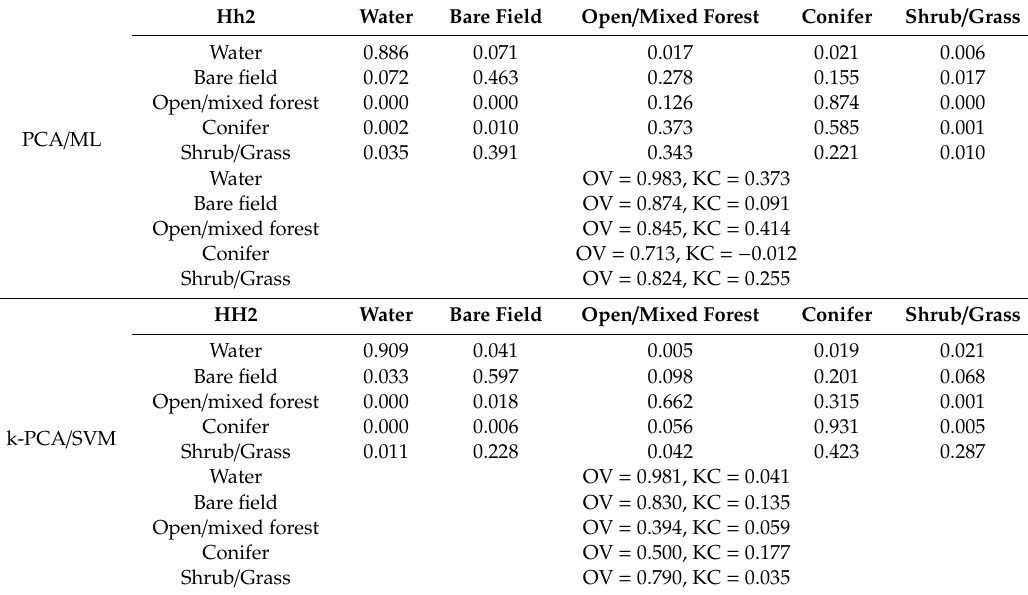
Table 4. Confusion matrix of PCA / ML and k-PCA / SVM classification scheme over Mt. Baekdu. Together with OV and